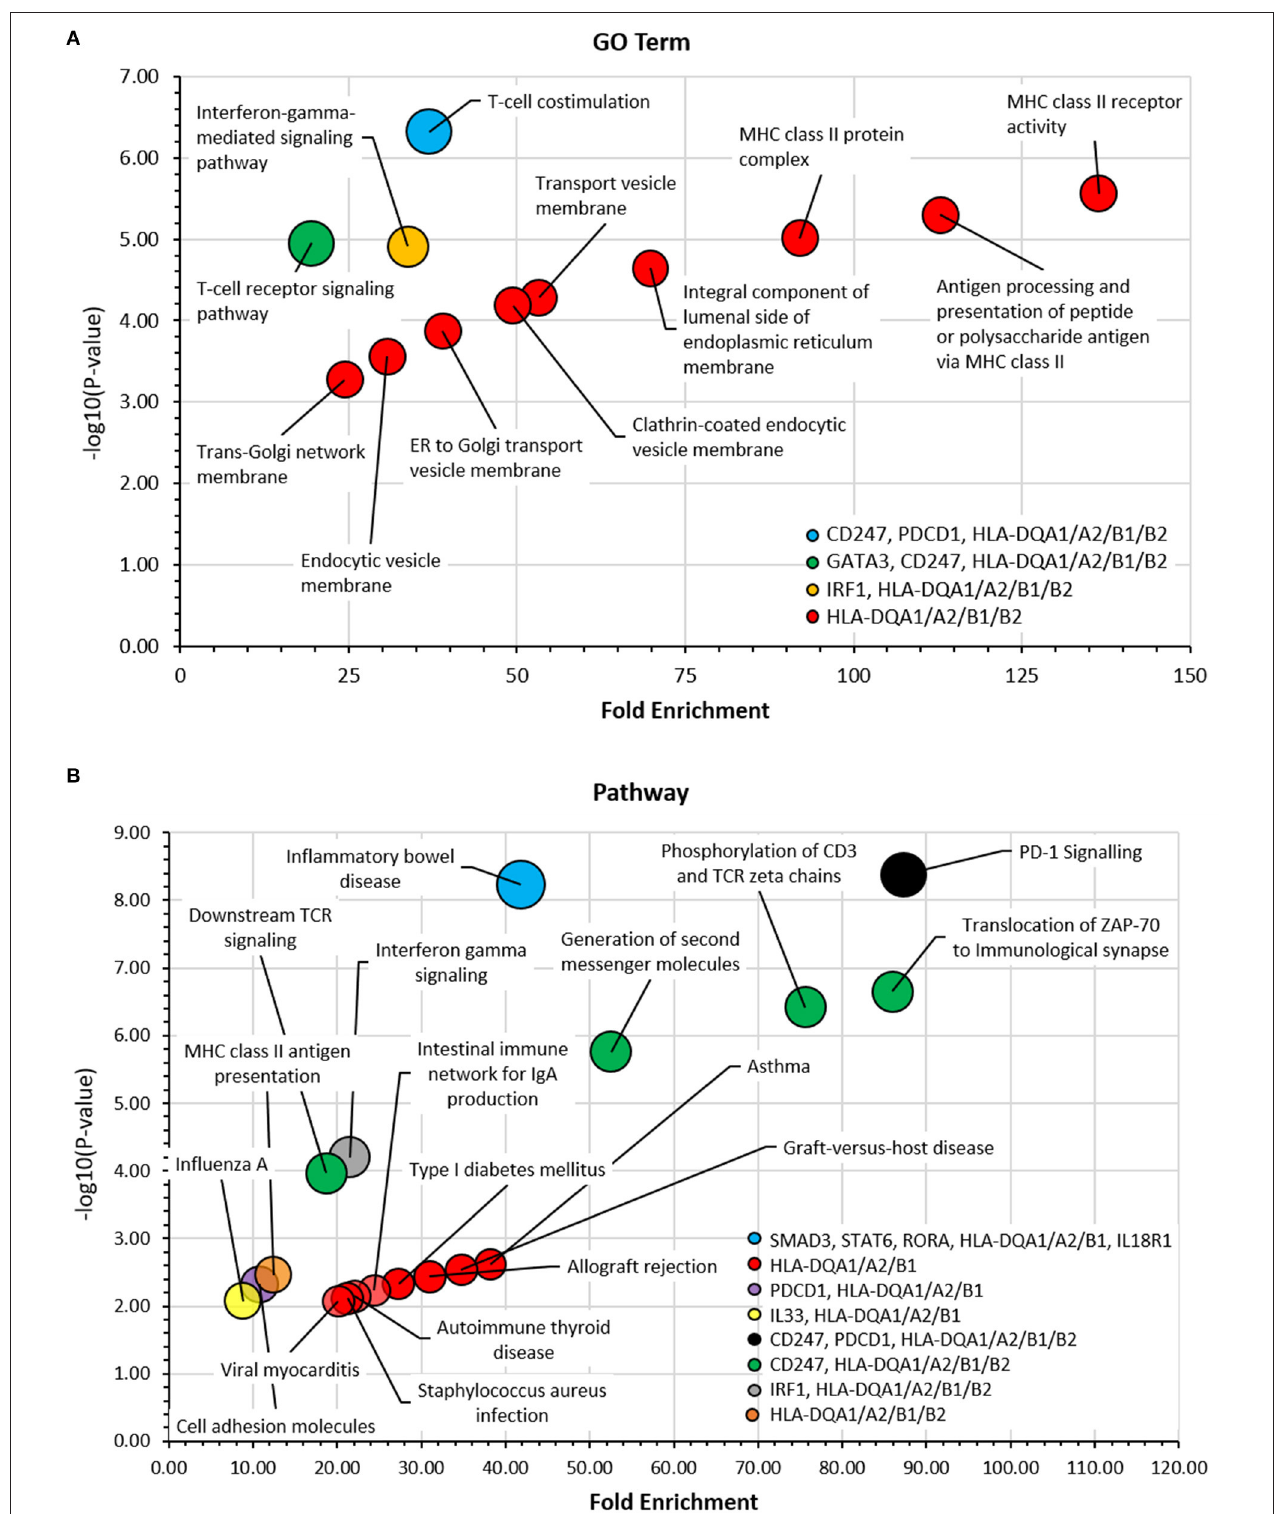
FIGURE 7 | Gene ontology (GO) term and pathway analyses. The DAVID bioinformatic tools was used to assess candidate genes in (A) GO Term and (B) KEGG and REACTOME Pathway analyses. -log 10 ( p -value) was plotted against fold enrichment for gene groups and the area of the circle is proportional to number of genes in the group. 5% FDR. Full analyses can be viewed in Supplementary Tables 5, 6 .